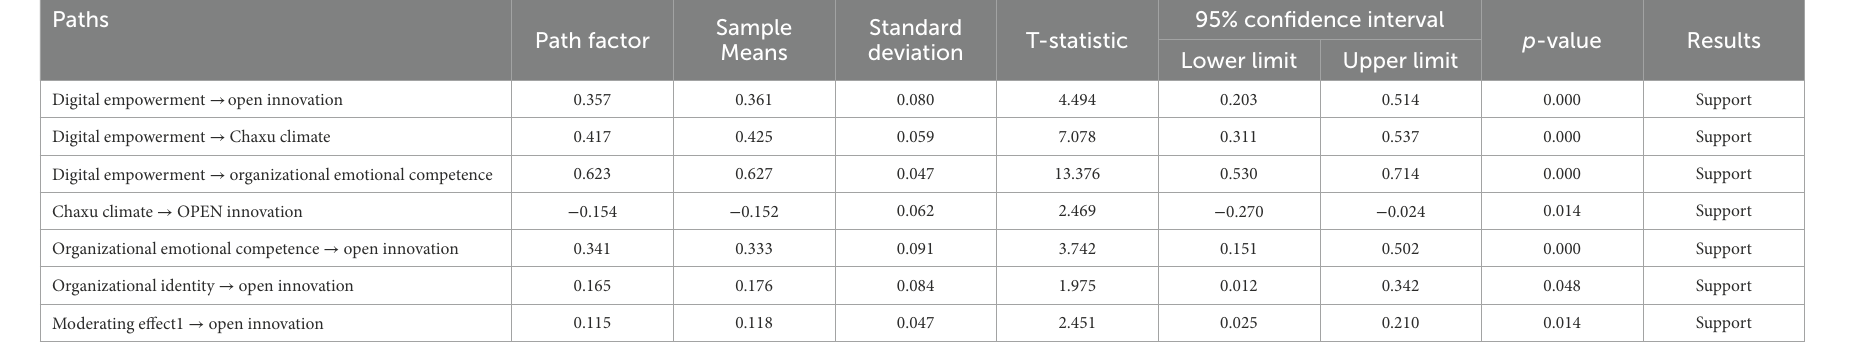
TABLE 5 Research hypothesis testing.